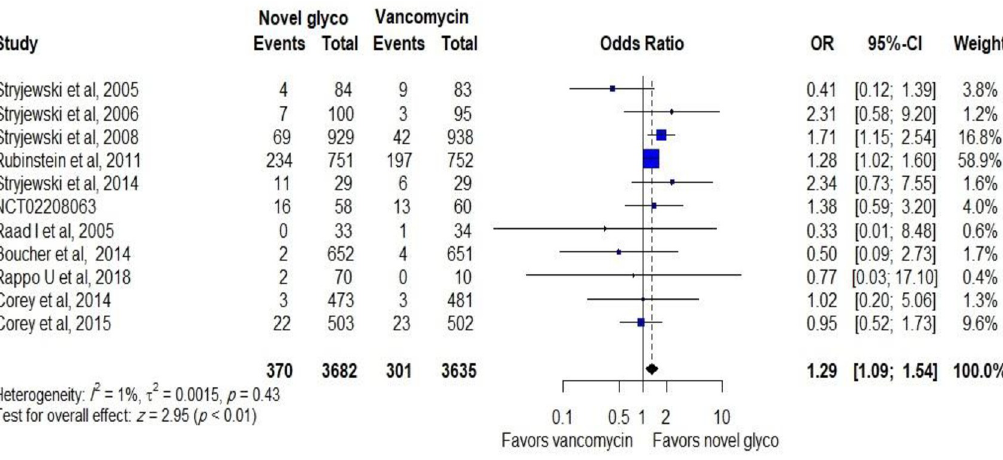
Fig 6. Serious adverse events of novel glycopeptides against vancomycin in the modified intent-to-treat populations.